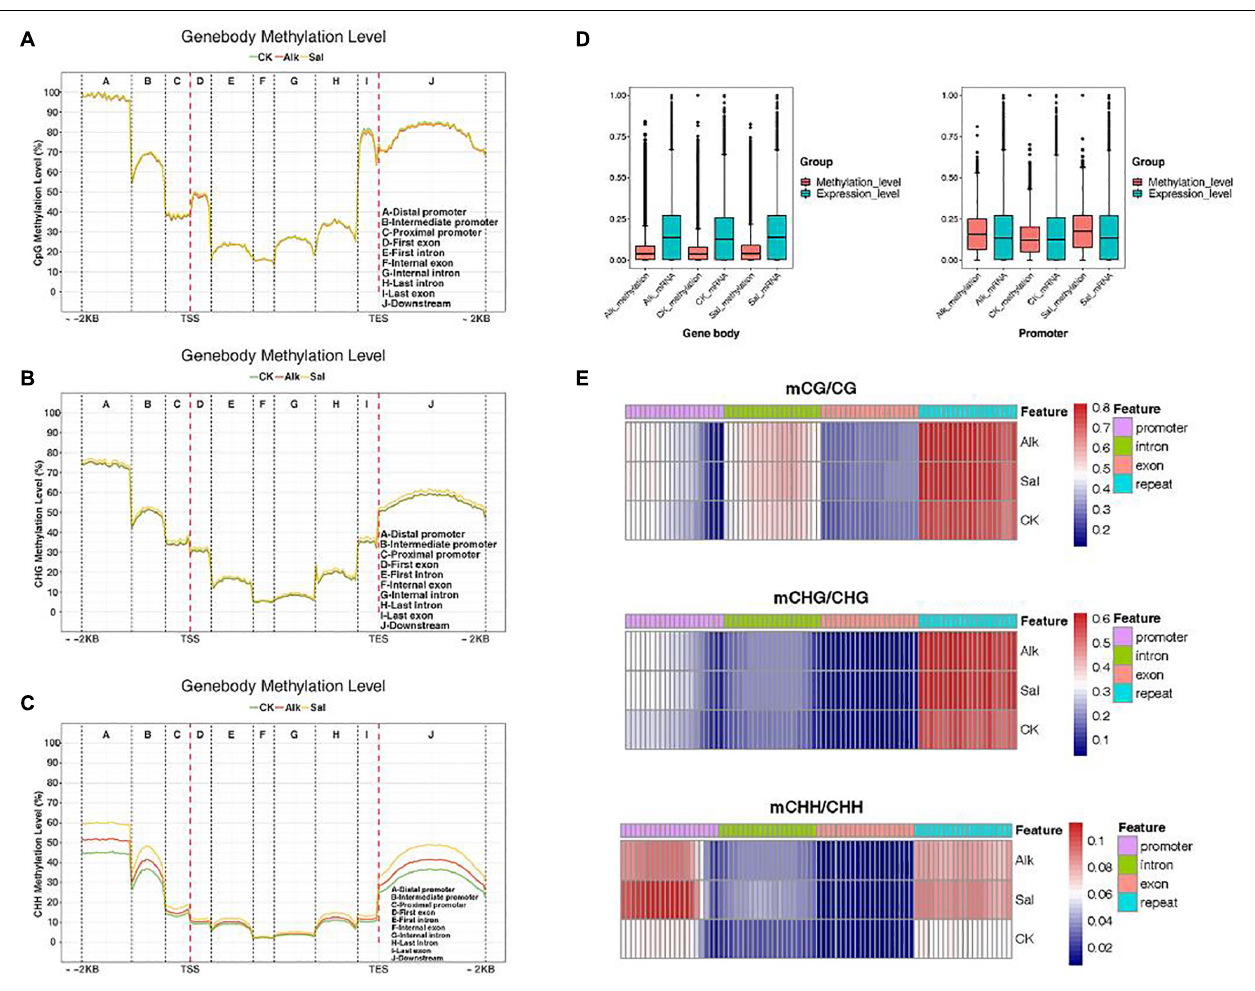
FIGURE 4 | DNA methylation patterns in different genomic regions. (A–C) Statistics of methylation distribution of different gene segments. The X -axis represents different regions of the genome. (D) Box plots of methylation levels and gene expression levels in gene bodies and promoter regions [FPKM value was estimated by log10 (FPKM + 1)/max log10 (FPKM + 1)]. (E) Analysis of the heat map of the methylation level of gene